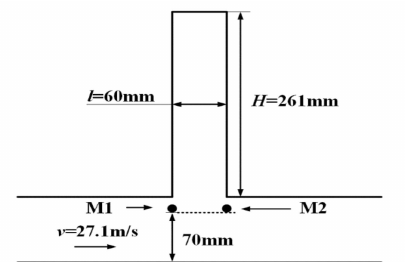
Figure 5. The numerical model of the 261 mm depth